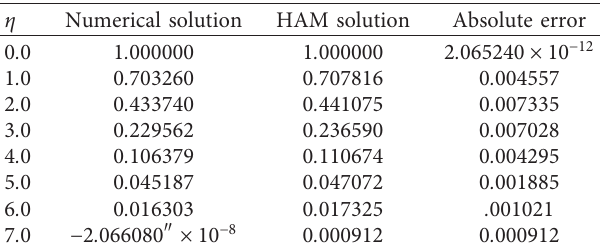
Table 3: Numerical solution via the analytical solution for the nanoparticle concentration φ ( η ) profile.